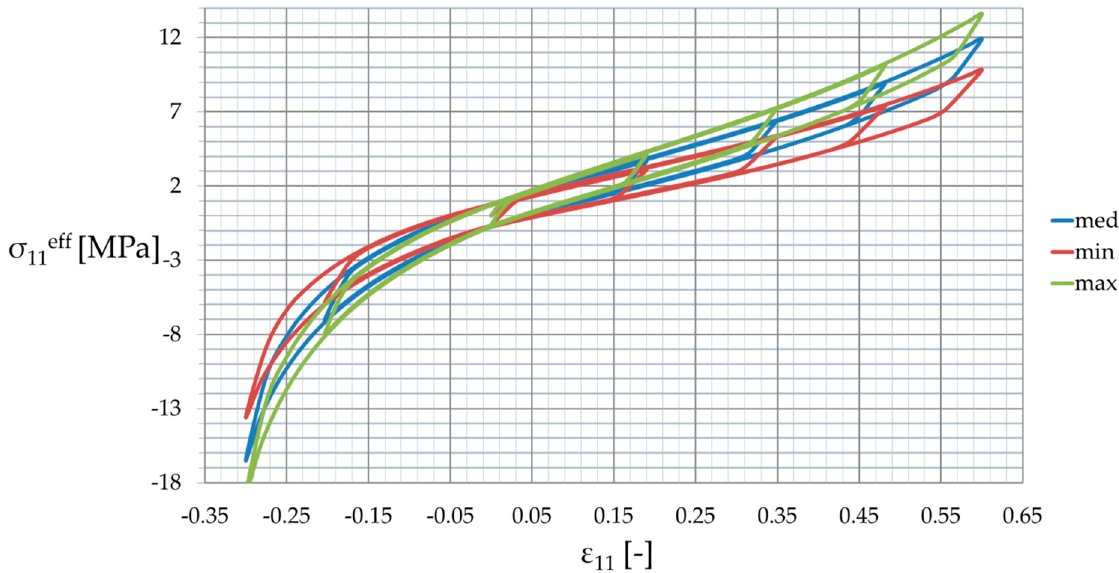
Figure 6. E ff ective response for the Figure 6. Effective response for the elastomer.